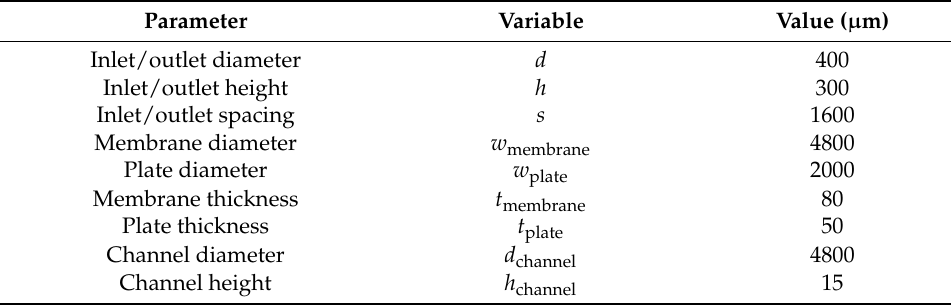
Table 1. Summary of the micro valve